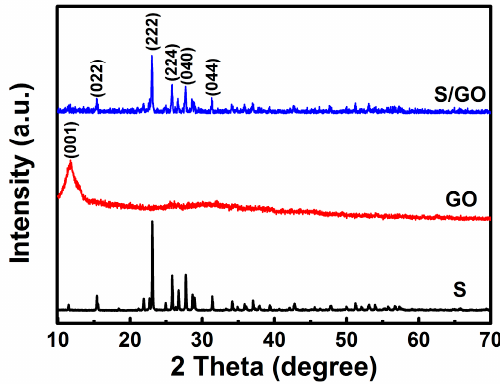
Figure 1. XRD patterns of S, GO, and S/GO composite powders.